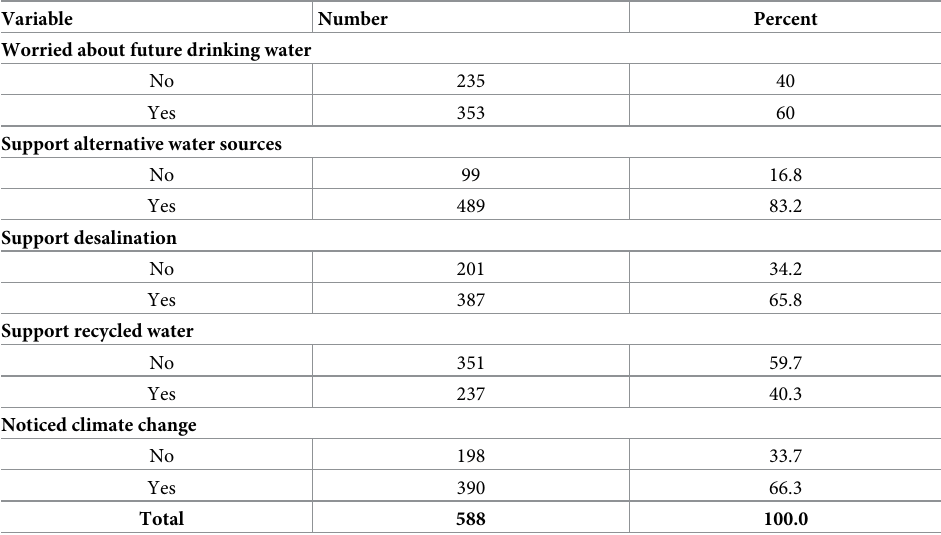
Table 2. Distribution of the responses to water scarcity, alternative potable water sources and climate change.